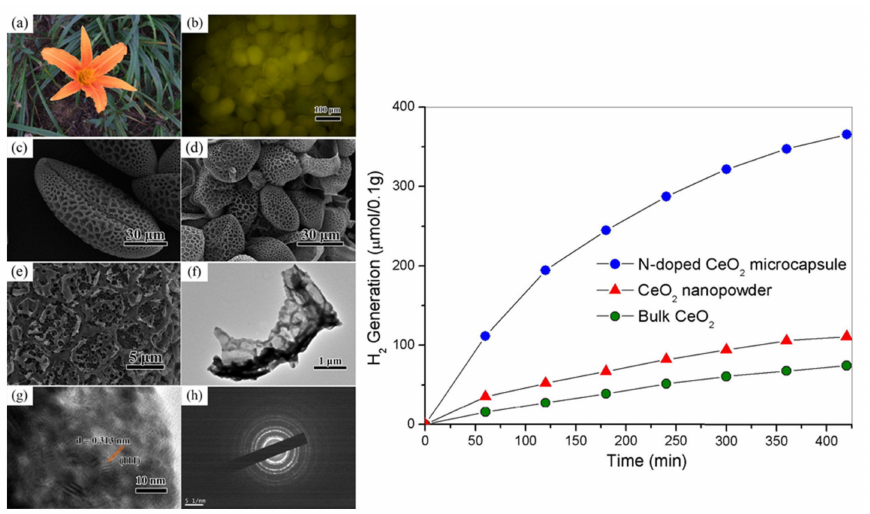
Figure 3. Figure extracted from Liu et al. (2017) [140]. Picture ( a ) is an image of the template Hemerocallis fulva and ( b ) is a fluoroscopy photograph of pollen. Pictures ( c , d ) show SEM images of both the original template and the templated material, respectively and ( e ) shows the porous surface of biotemplated CeO 2 microcapsule at a lower scale. Pictures ( f – h ) show the TEM image of the templated CeO 2 microcapsule, HRTEM image of the templated CeO 2 microcapsule and the selected area diffraction pattern of CeO 2 nanoparticles, respectively. The right picture also shows hydrogen production comparing the templated material (N-doped CeO 2 microcapsules) with non-templated forms of CeO 2 . Reproduced with the permission of